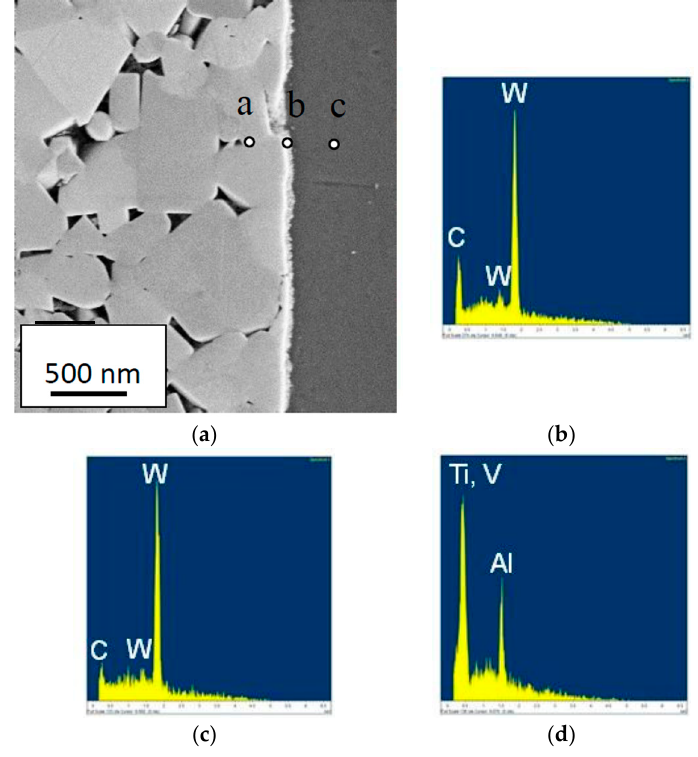
Figure 15. Cross-section of the crater ( a ) showing diffusion layer (white) and high resolution (EDS) spectra (E 0 = 5 keV) obtained within; a surface WC grain ( b ), the diffusion layer ( c ) and the adhered work material layer ( d ).